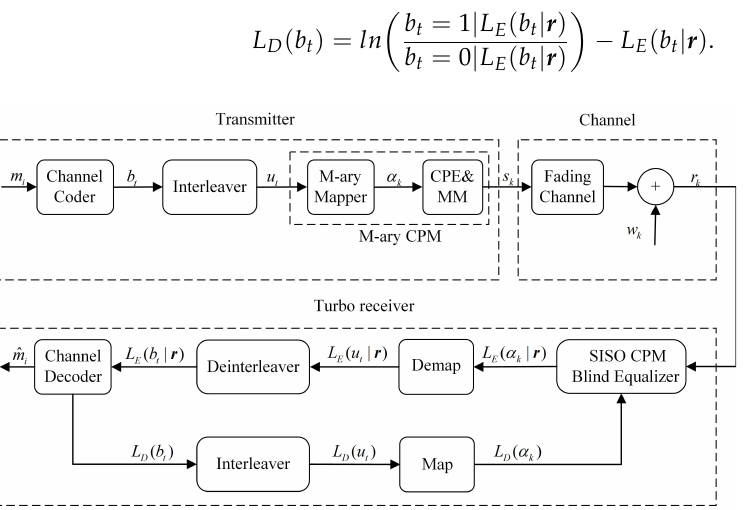
Figure 1. Communications system model, including the transmitter, channel, and turbo receiver.